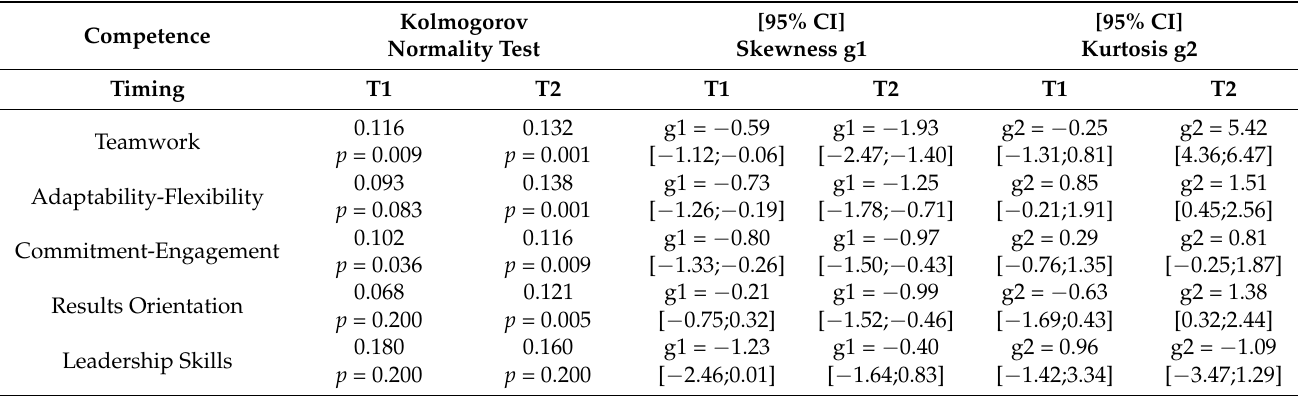
Table 2. Kolmogorov–Smirnov normality tests, and 95% CI of Bliss skewness (g1) and kurtosis (g2) indexes, for the global ratings of all